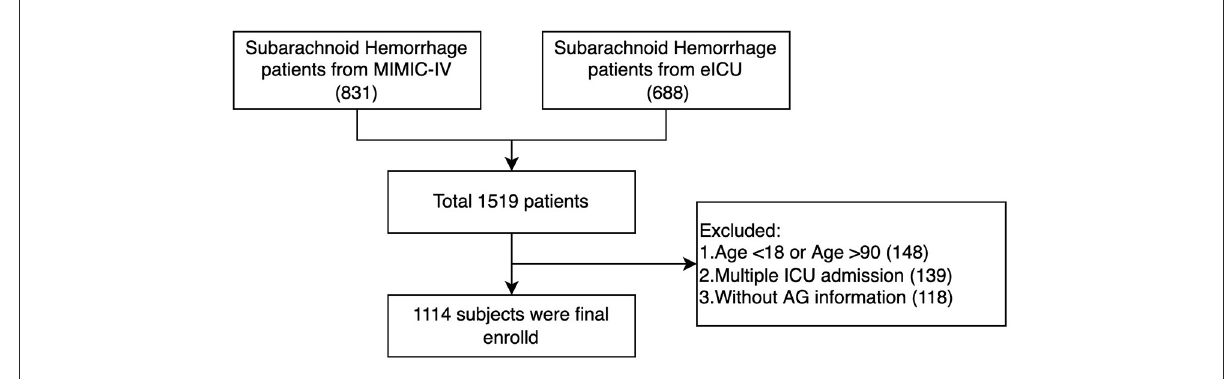
FIGURE1 Flow charts of patient